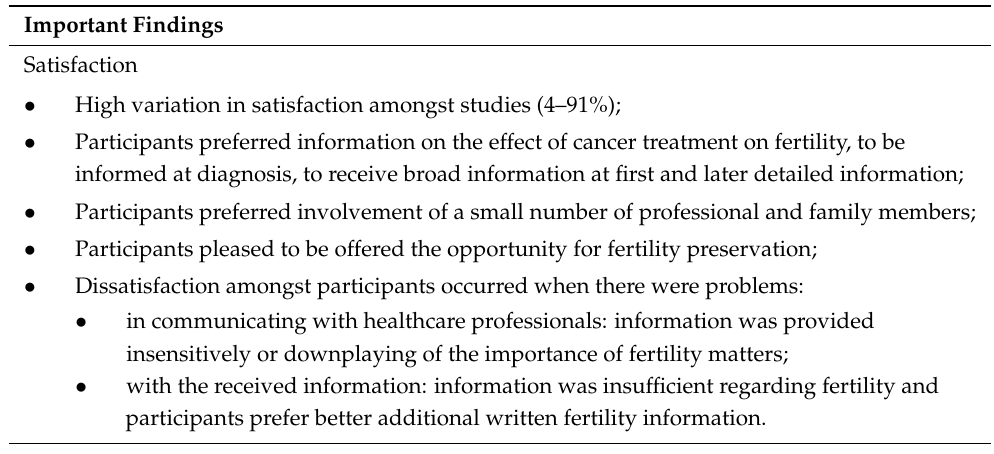
Table 4. Important findings of included